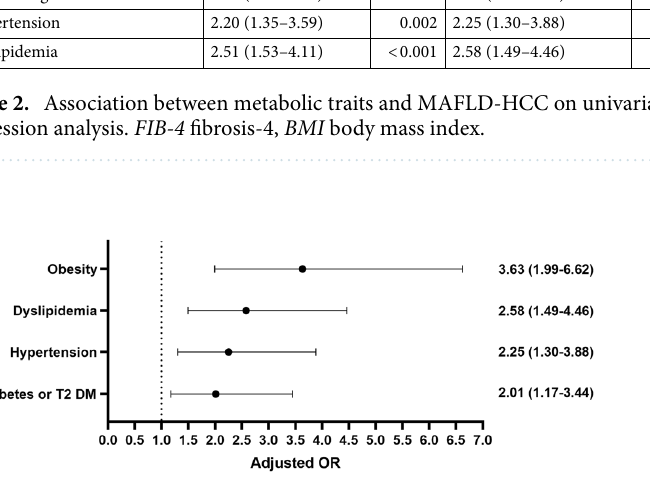
Figure 2. Adjusted associations between metabolic traits and MAFLD-HCC on multivariate logistic regression analysis. T2 DM type II